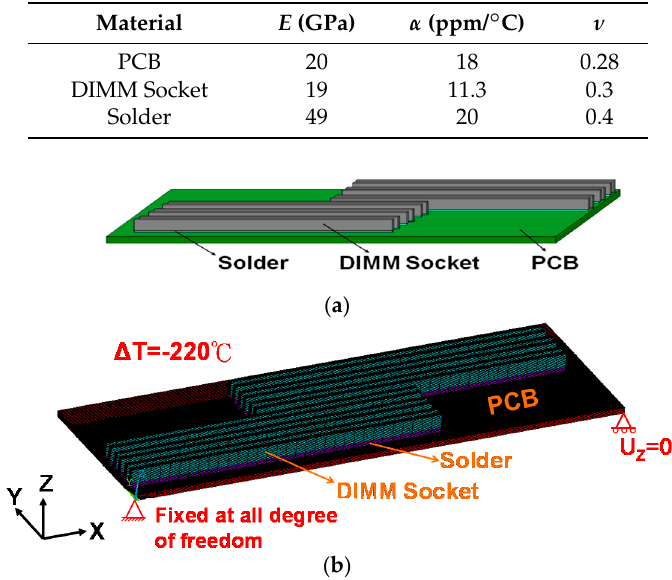
Figure 3. ( a ) Schematic drawing and ( b ) the modeling of the PCB with DIMM sockets in the finite element method (FEM) simulation.